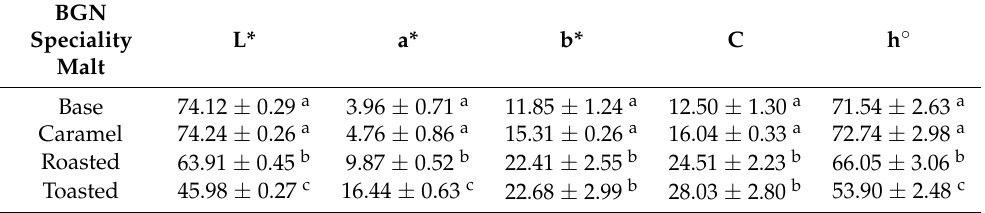
Table 1. Colour characteristics of Bambara groundnut speciality malt 1 .